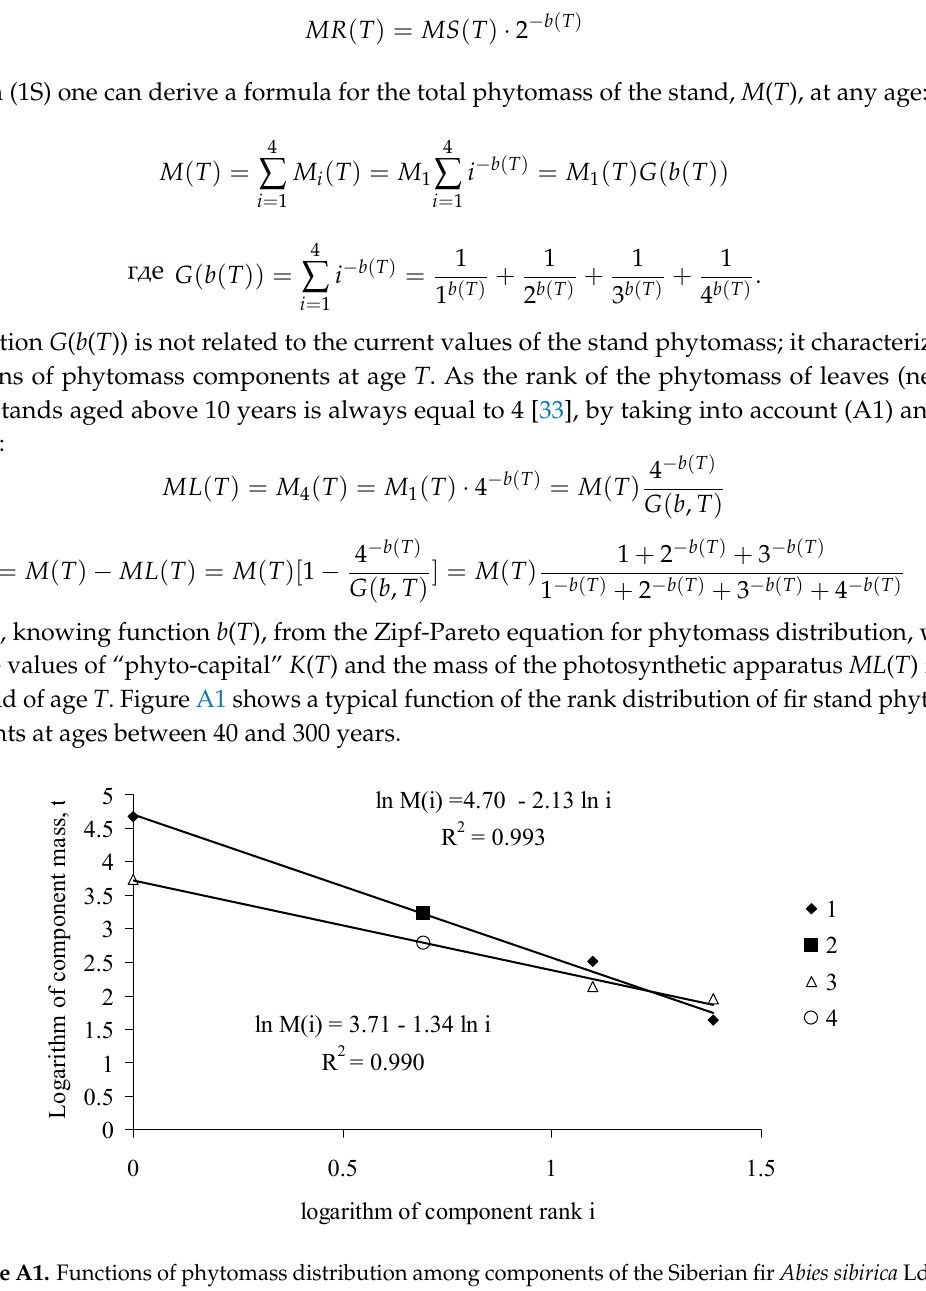
Figure A1. Functions of phytomass distribution among components of the Siberian fir Abies sibirica Ldb. stand (the West Sayan Mountains, the upper reaches of the Kebezh River, 52°N, 89°E) at ages of 40 and 300 years. ( 1 ) aboveground components of tree phytomass in the 300-year-old stand; ( 2 ) calculated root phytomass in the 300-year-old stand; ( 3 ) aboveground components of tree phytomass in the 40-year-old stand; ( 4 ) calculated root phytomass in the 40-year-old stand [10]. Equation (A2) can be regarded as a regression equation with the known values of phytomasses and ranks of phytomasses, for which one should calculate its coefficients. Assuming that the root phytomass of the Siberian fir is a rank 2 component, the values of the phytomasses of aboveground tree components are described with high accuracy (R 2 > 0.99) by Equation (A2) (Figure A1). Knowing coefficients of regression Equation (A2), one can calculate root phytomass. The method described above was used to determine the ranks of roots and to calculate the values of root phytomass in forest stands. Is Equation (A2) sufficiently accurate? Figure A2 shows the distribution of coefficients of determination, R 2 , for the data on the distribution of phytomass in forest stands among tree components.